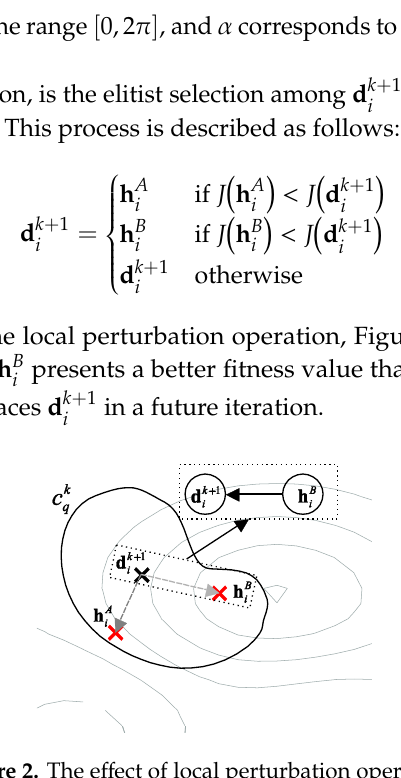
Figure 2. The effect of local perturbation operation. Figure 2. The e ff ect of local perturbation